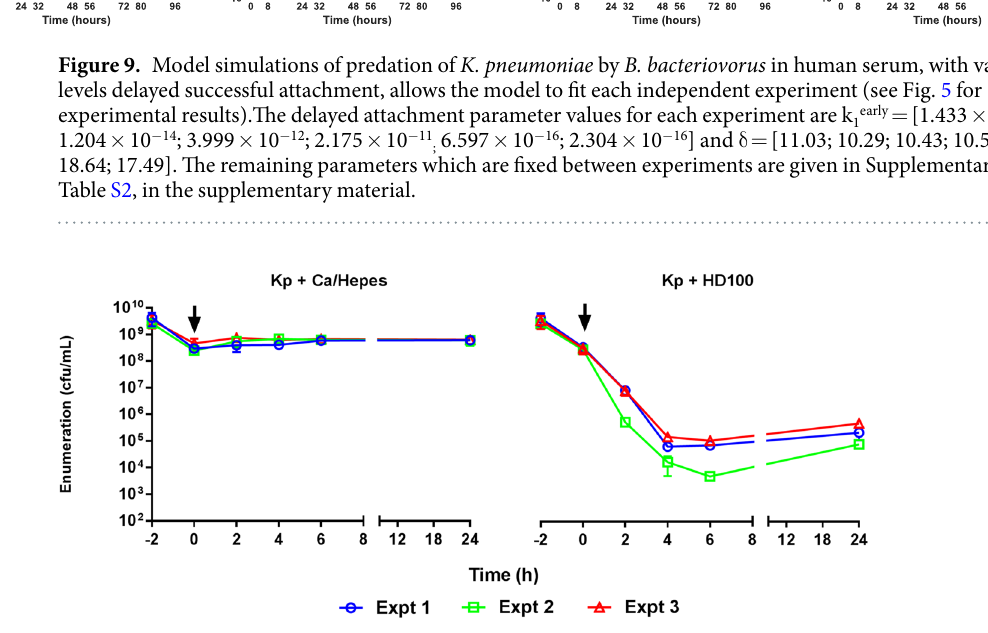
Figure 10. Predation in Ca/HEPES showing live bacterial numbers following pre-exposure of predator and prey to human serum. B. bacteriovorus HD100 and K. pneumoniae were exposed to human serum for two hours (t = − 2 to 0 h). Predator and prey were then resuspended in Ca/HEPES and combined together in a predation assay and changes in the K. pneumoniae prey population enumerated periodically (Kp + HD100). As a control, K. pneumoniae prey previously exposed to human serum was resuspended in Ca/HEPES and enumerated periodically in the absence of B. bacteriovorus HD100 predator (Kp + Ca/HEPES). Arrows indicate the time at which bacteria were transferred from serum to buffer and subjected to respective treatment). B. bacteriovorus previously exposed to whole serum was added to K. pneumoniae to give a predator concentration at t = 0 h of approximately 5 × 10 8